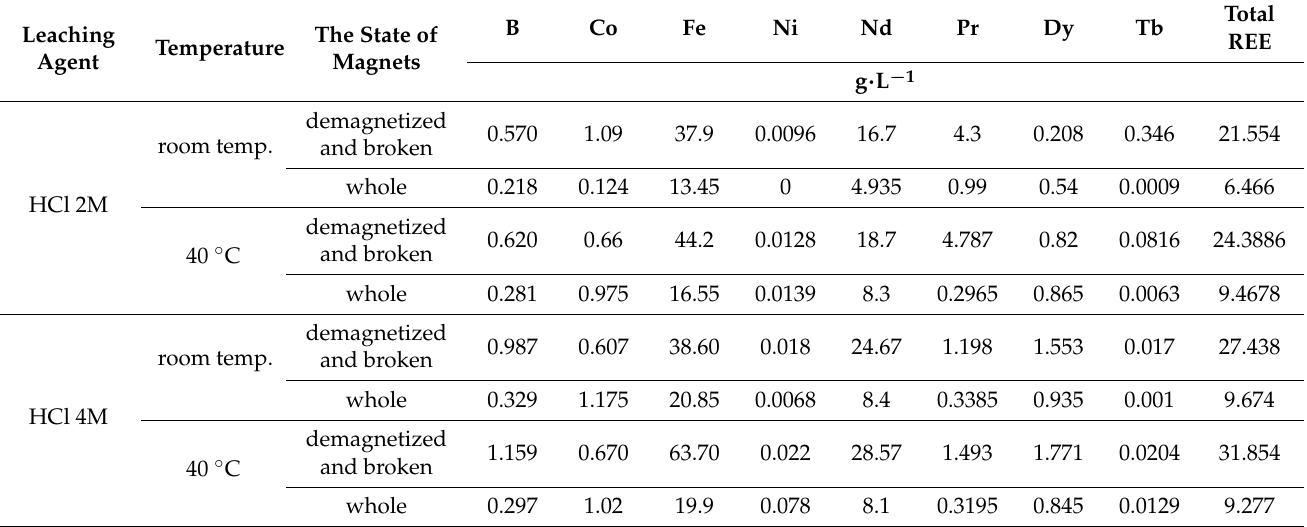
Table 6. Concentration of ions in the solutions obtained after the leaching of magnets in hydrochloric acid for 7 h. Leaching The State of Temperature Agent Magnets